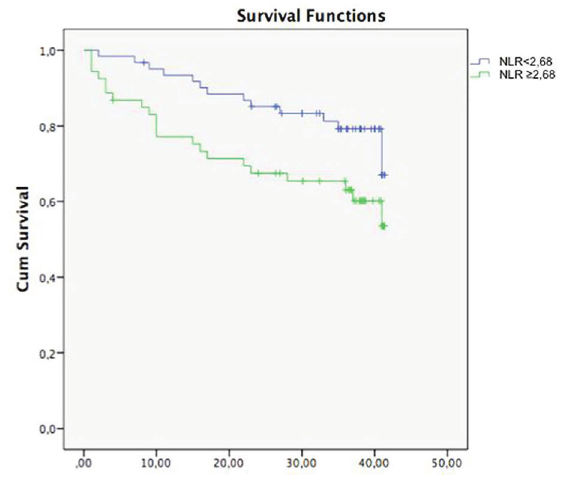
Figure 3 - Kaplan–Meier survival curve according to the effective cut-off value of the neutrophil-to-lymphocyte